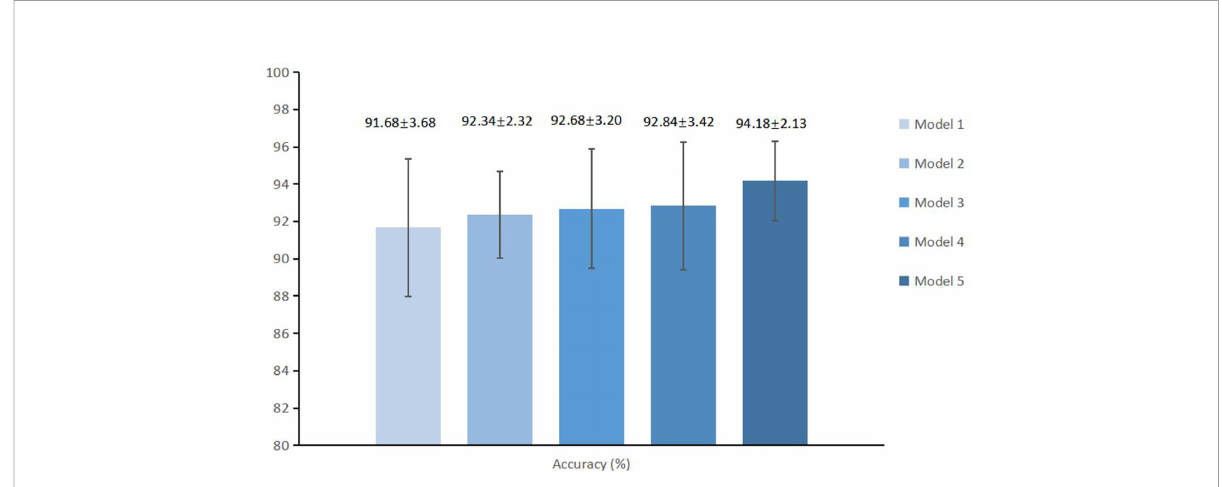
FIGURE 5 The average accuracy and standard deviations of different models. Model 1, Enhanced model; Model 2, Enhanced model with spatial morphological information; Model 3, Enhanced model with spatial morphological information and age; Model 4, Enhanced model with morphological information and gender; Model 5, MExPale model.